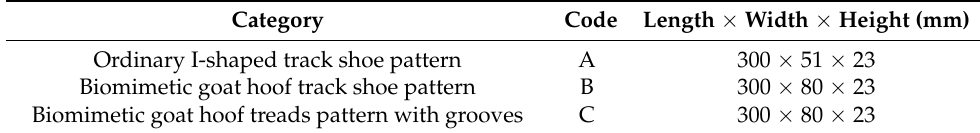
Table 1. Category and size parameters for the code and test